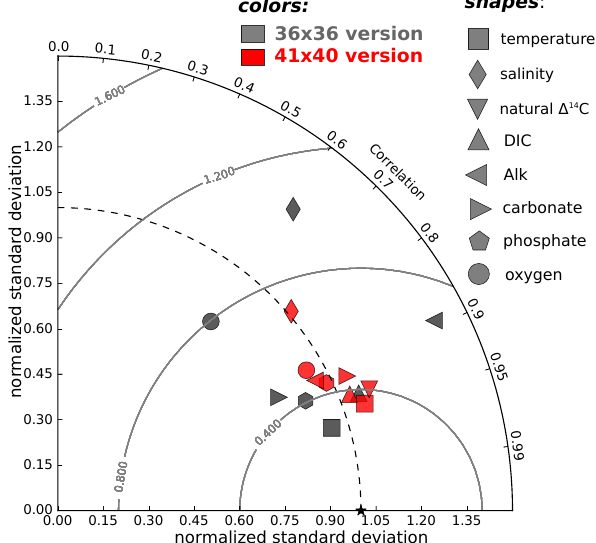
Figure A1. Taylor diagram for global, volume-weighted oceanic tracer distributions. Results from the previous (36 × 36) model version are shown by grey and results from the updated version (41 × 40) by red